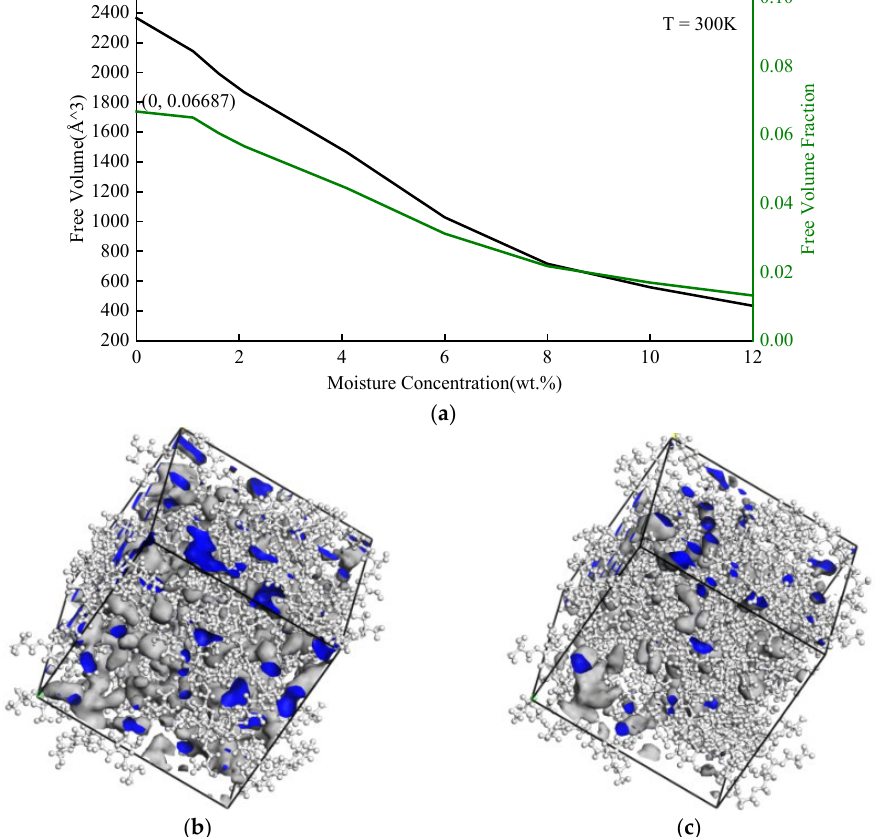
Figure 8. ( a ) Free volume of various moisture concentrations. Free volume distribution at moisture concentration of ( b ) 0 wt.% and ( c ) 12 wt.%. The envelope on the blue side is free volume.